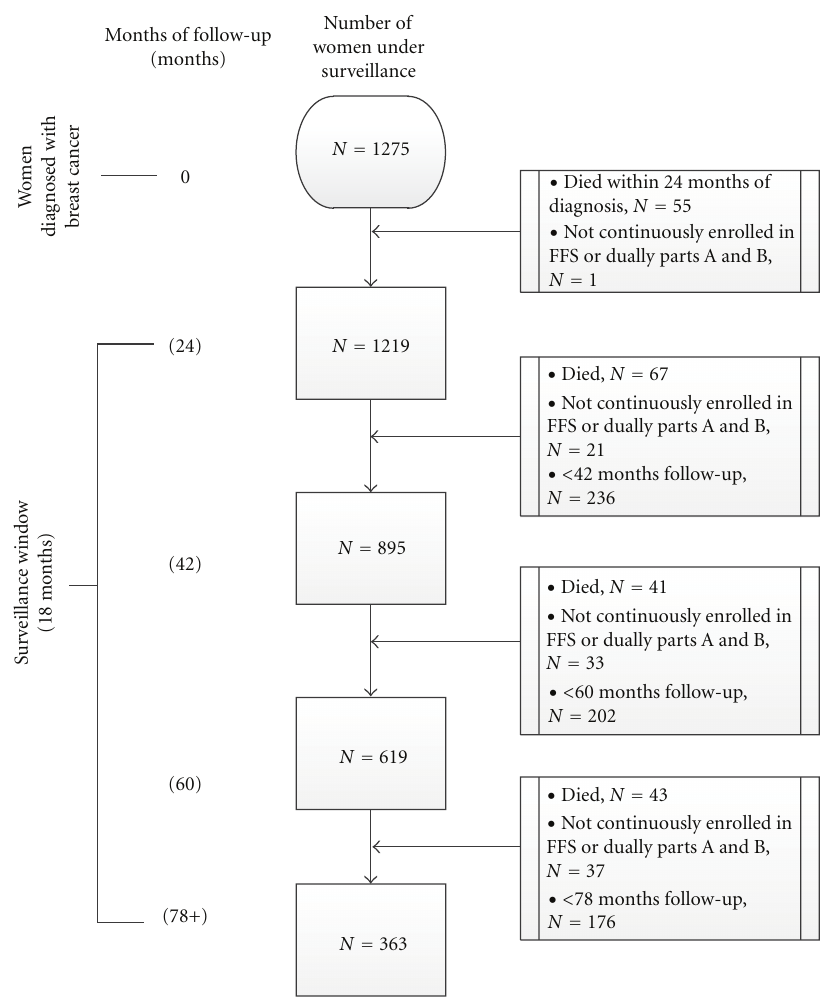
Figure 1: Surveillance